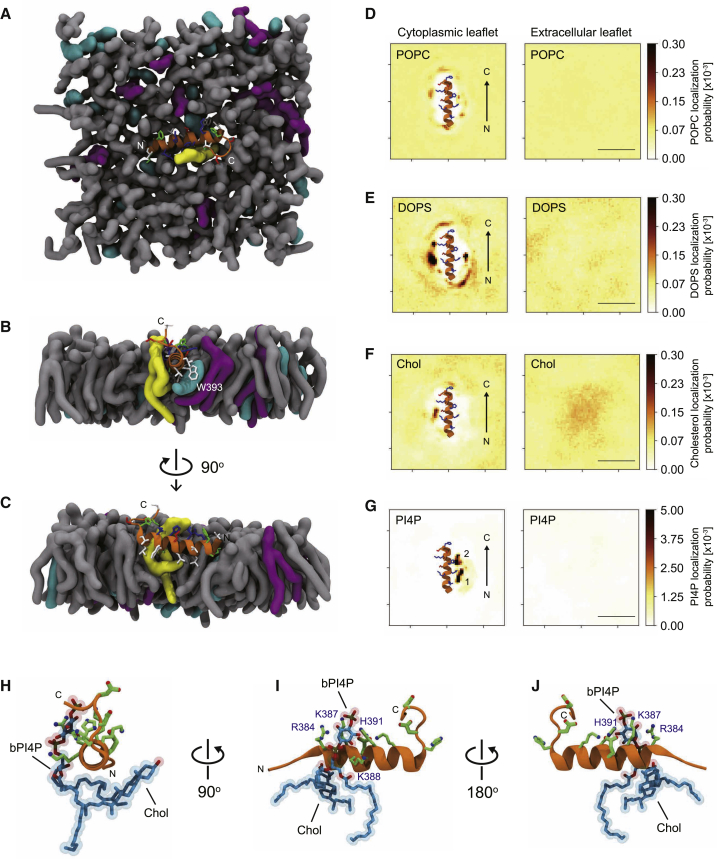
Molecular View of the PIP5K Specificity Loop Embedded in a Lipid Bilayer(A–C) The specificity loop of PIP5K (5Kloop) embedded into a model membrane bilayer in atomistic molecular dynamics simulations. The 5Kloop is shown as ribbon (orange) with hydrophobic, polar, acidic, and basic amino acids represented as sticks in white, green, red, and blue, respectively. The surfaces of lipids and sterols are shown for POPC (gray), DOPS (magenta), cholesterol (cyan), and bPI4P (yellow). The figure shows an area of the membrane leaflet of approximately 4 × 4 nm (A). Cross sectional views of the 5Kloop embedded in the model membrane bilayer (B and C). Water and ions outside the membrane are omitted for clarity.(D–G) Lipid localization. Time-averaged positions of the phosphate moieties of the phospholipids POPC (D), DOPS (E), and PI4P (G) or oxygen atoms in cholesterol (Chol, F) from all-atom molecular dynamics simulations of a model membrane bilayer. Colors indicate the localization probability of different lipids over the course of the whole 10-μs trajectory. The membrane leaflet (cytoplasmic) with the 5Kloop embedded is shown in the left panels; the opposing leaflet (extracellular) is shown on the right. Scale bars, 2.5 nm.(H–J) Atomistic views of the bPI4P molecule interacting with pocket #1 of the 5Kloop with a cholesterol molecule on the other side as shown in Figure 7B (H); 90° orientation (I); 180° orientation (J). The two phosphate moieties of bPI4P interact with four basic residues of the amphipathic helix (R384, K387, K388, and H391). The cholesterol hydrocarbon chain wedges between the acyl chains of the polyunsaturated PI4P. The amphipathic helix is visualized as a ribbon (orange) and acidic and basic residues as sticks in green. Positively charged nitrogen atoms and negatively charged oxygen atoms are shown as spheres, colored blue and red, respectively.See also Figure S7.